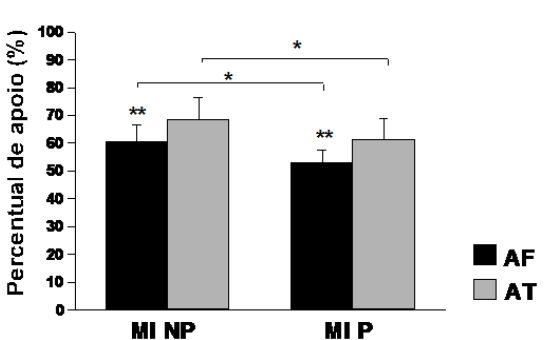
Figura 1. Média e desvio padrão do percentual de apoio do membro inferior (MI) não parético (NP) e MI parético (P) no andar para frente (AF) e no andar para trás (AT). Os asteriscos (*) indicam diferenças significativas entre os membros * e entre as direções ** para